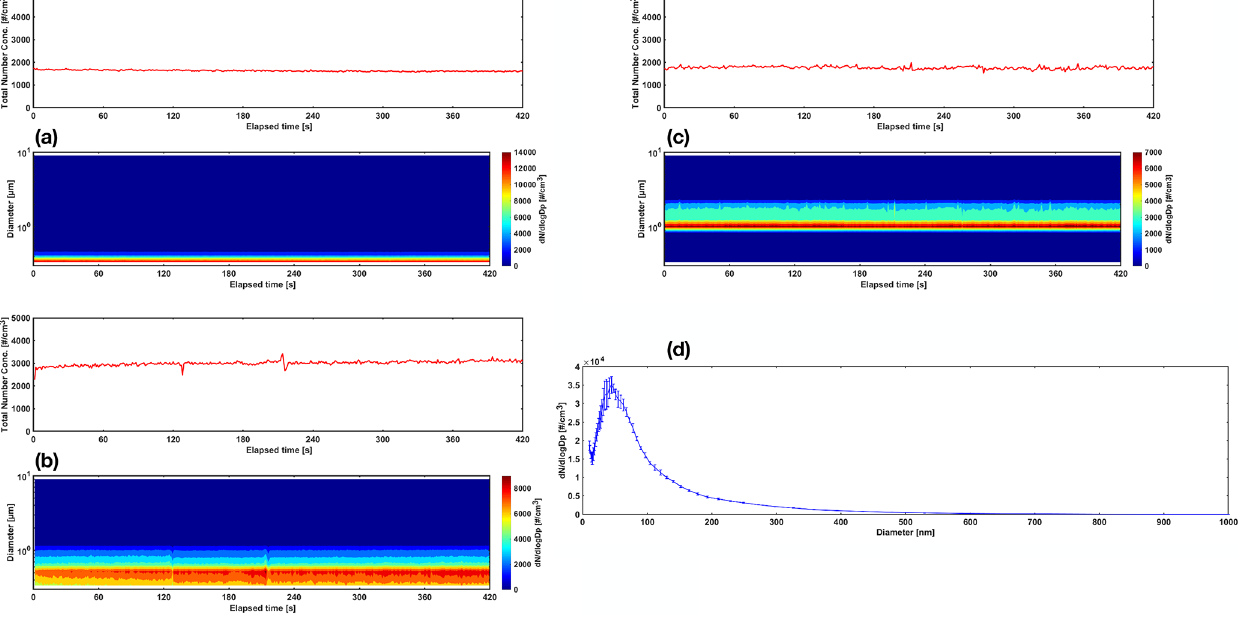
Figure 4. Total particle number concentrations and particle number size distributions as a function of time of aqueous ammonium sulfate particles: (a) 0.1gL − 1 , (b) 0.6gL − 1 , (c) 5.0gL − 1 . (d) Average particle number size distribution from 10 to 1000nm measured with the SEMS for aqueous ammonium sulfate particles of 0.6gL − 1